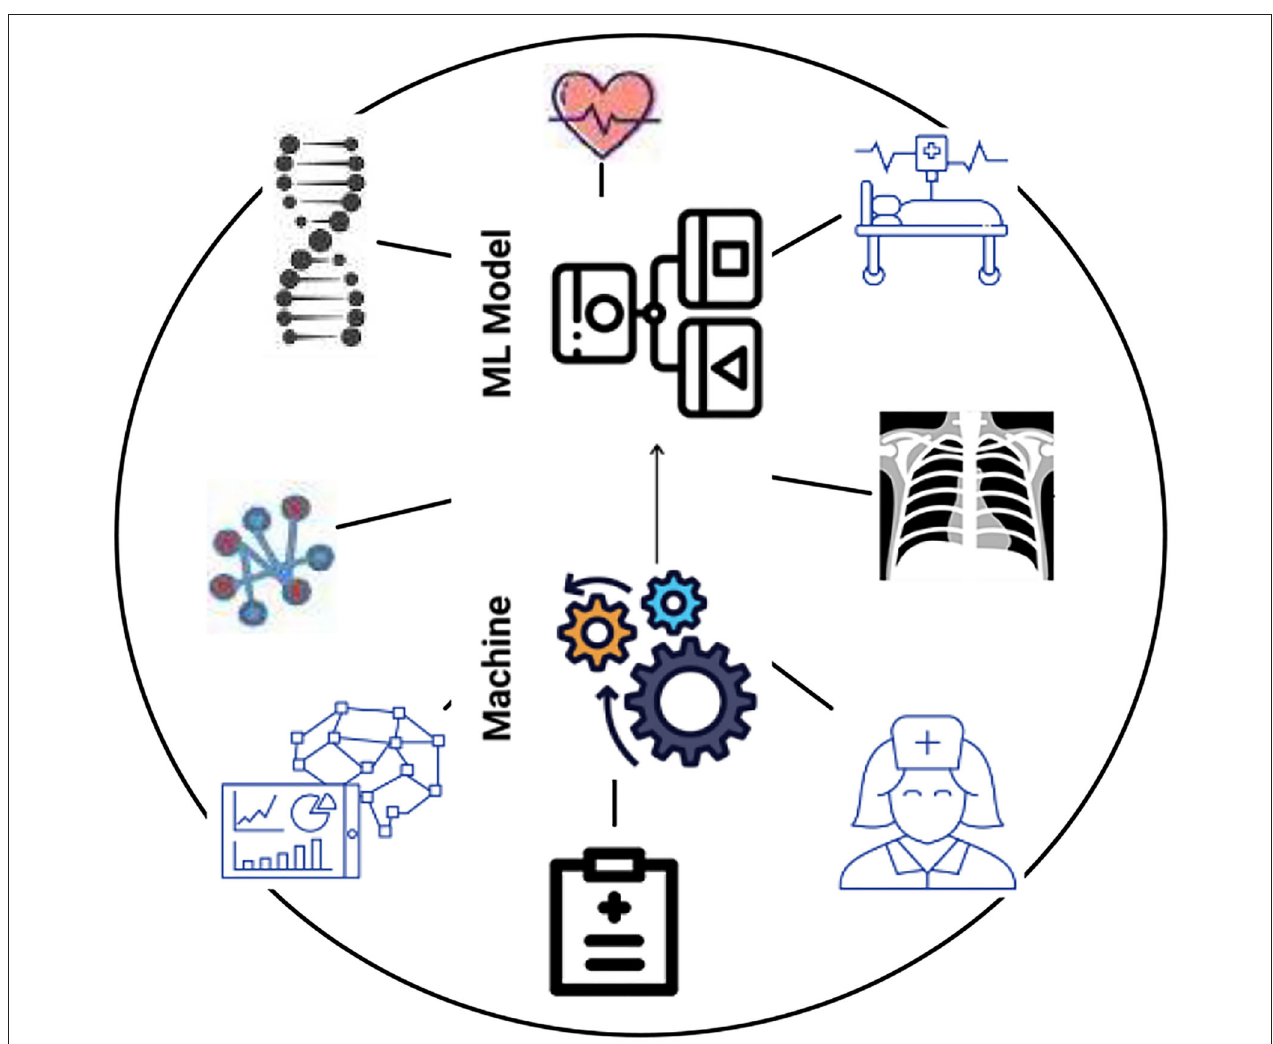
FIGURE 5 | The main applications of ML-based techniques for medical